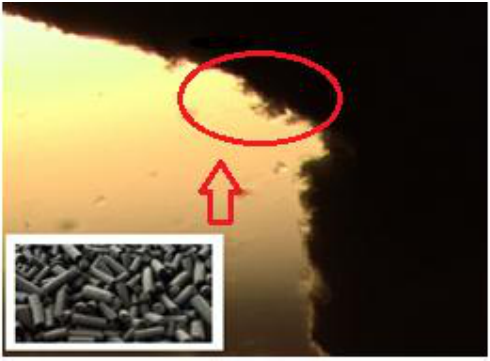
Figure 5. Edge of granular activated carbon grain covered with biological membrane (photos from a light microscope).